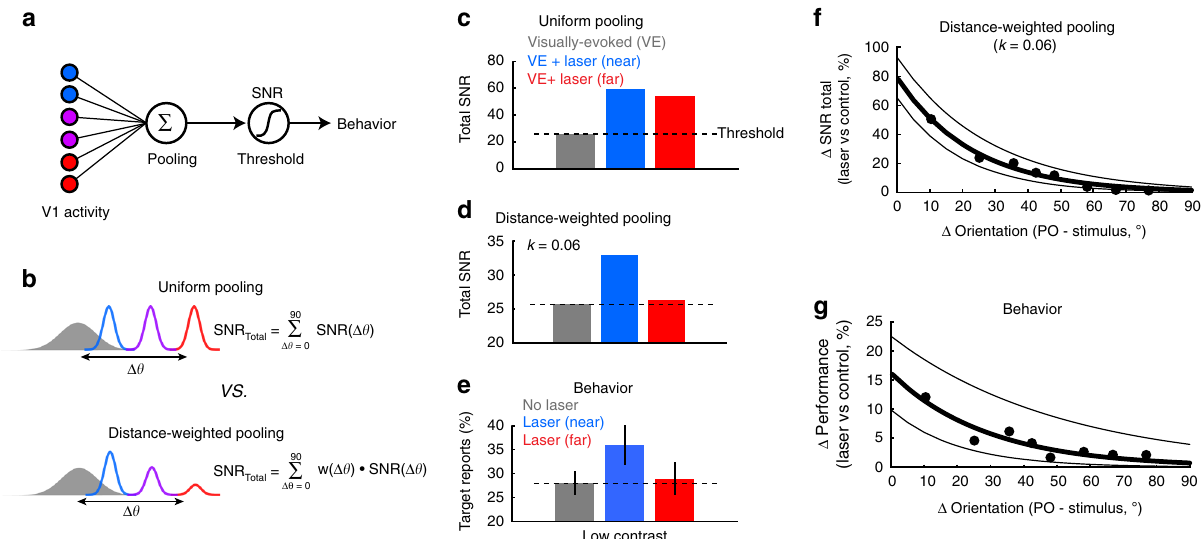
Fig. 5 Functional distance-weighted pooling correlates best with detection performance. a Basic model of sensory detection relying on pooling signals across neural populations. Stimulus detection requires the pooled signals from V1 (colors represent different tuning preferences) to exceed a critical SNR threshold. b Two possible models of signal pooling. Upper A uniform pooling rule in which the total SNR is based equally on the sum of the visually driven response (gray, fi lled distribution) and the laser-driven response (colored, un fi lled distributions), regardless of tuning difference (colors). Lower A distance- weighted pooling rule, in which the contribution of the laser-driven population is weighted by its orientation-difference from the visually driven population. The weight (w) is a simple exponential decay (see main text). c Total SNR predicted by uniform pooling for low contrast stimuli. The laser-driven neuronal activation in both the “ near ” (blue) and “ far ” (red) conditions substantially increases total SNR above the control condition (gray). Dashed black horizontal line estimates the global SNR threshold based on the control condition. d Total SNR predicted by functional distance (difference in orientation) weighted pooling for low contrast stimuli. Only the laser-driven neuronal activation in the “ near ” condition (blue) increases the total SNR substantially above the control condition, matching well with the laser-induced change in behavior ( e ). e Behavioral detection performance for low contrast stimuli in the absence of laser stimulation (gray), and with laser stimulation in the “ near ” (blue), and “ far ” (red) conditions. Error bars represent s.e.m. across sessions. Dashed black horizontal line estimates the detection threshold based on the control condition. f Percent change in total SNR following laser stimulation using functional distance-weighted pooling, calculated as a function of the orientation difference between the laser and visually driven populations. SNRs were estimated from bootstrapped data sampled every 10 sessions (ordered by Δθ ), sliding every fi ve sessions. Thick black line shows an exponential fi t to the data points. Flanking thin black lines show the 95% con fi dence intervals for the fi t. g Change in behavioral performance (laser vs. control), averaged across the same sessions used in f . Thick black bar shows an exponential fi t to the data. Flanking thin black lines show the 95% con fi dence intervals for the fi